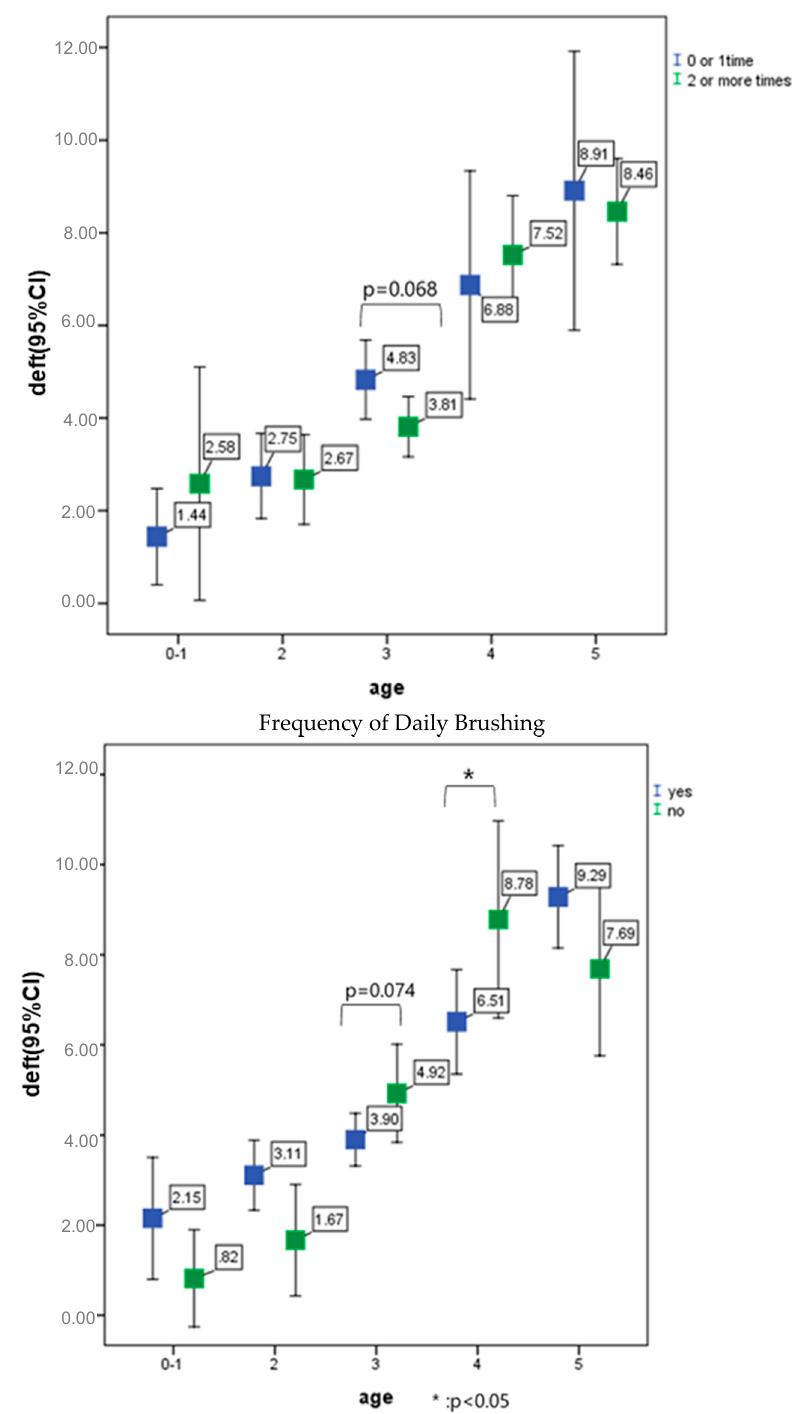
Figure 5. Correlation between parental educational attainment, child sex, frequency of sugary-snack intake per day, frequency of tooth cleaning per day, parental complete tooth cleaning after child itself, and deft index in October 2019.